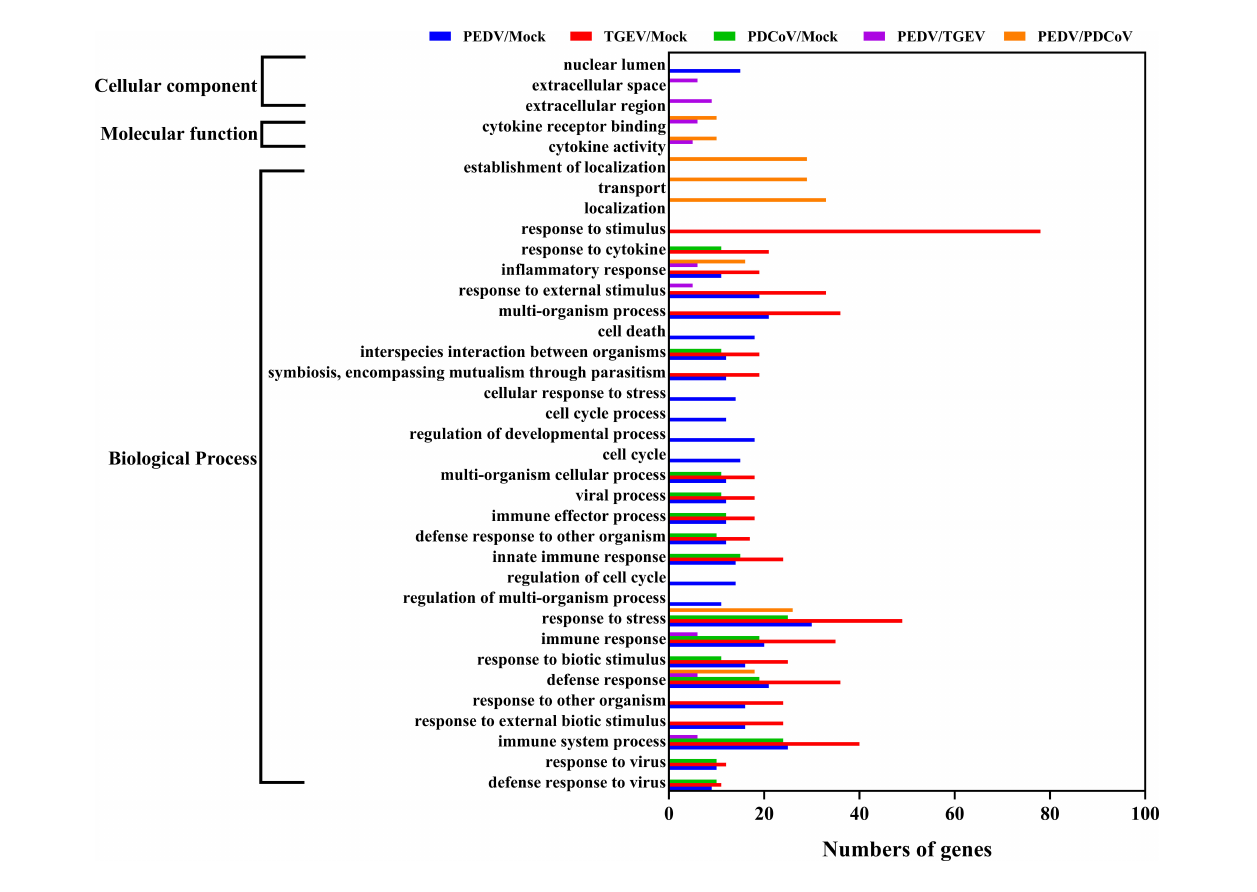
FIGURE 4 | GO enrichment analysis of PEDV, TGEV, or PDCoV